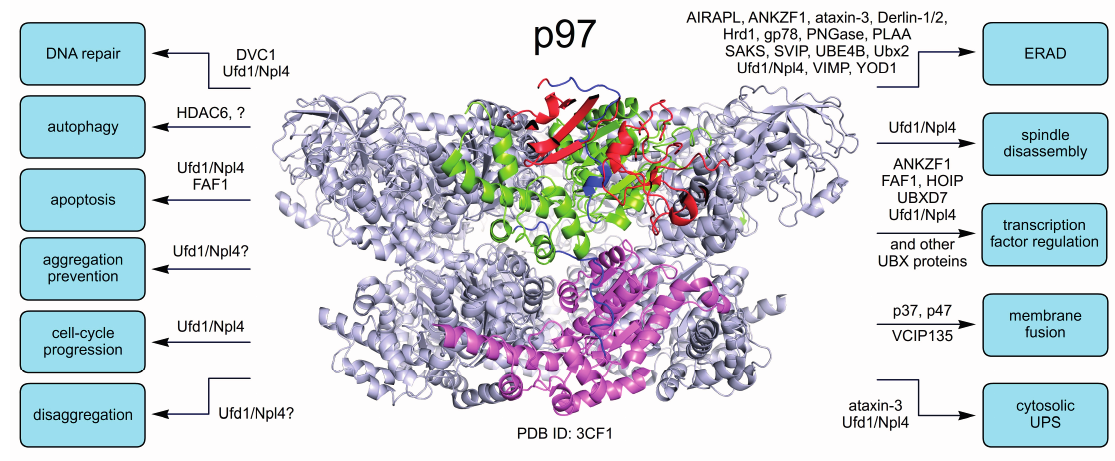
Figure 2. p97 function. The central image is from the highest resolution crystal structure of p97. Two contiguous subunits have been colored by domain: N-domains (red), D1-domains (green), D2-domains (magenta), and the linkers connecting the domains are shown (blue). As demonstrated in the light blue boxes, p97 is involved in a large number of biological processes, which are facilitated by a cohort of cofactors as shown over the